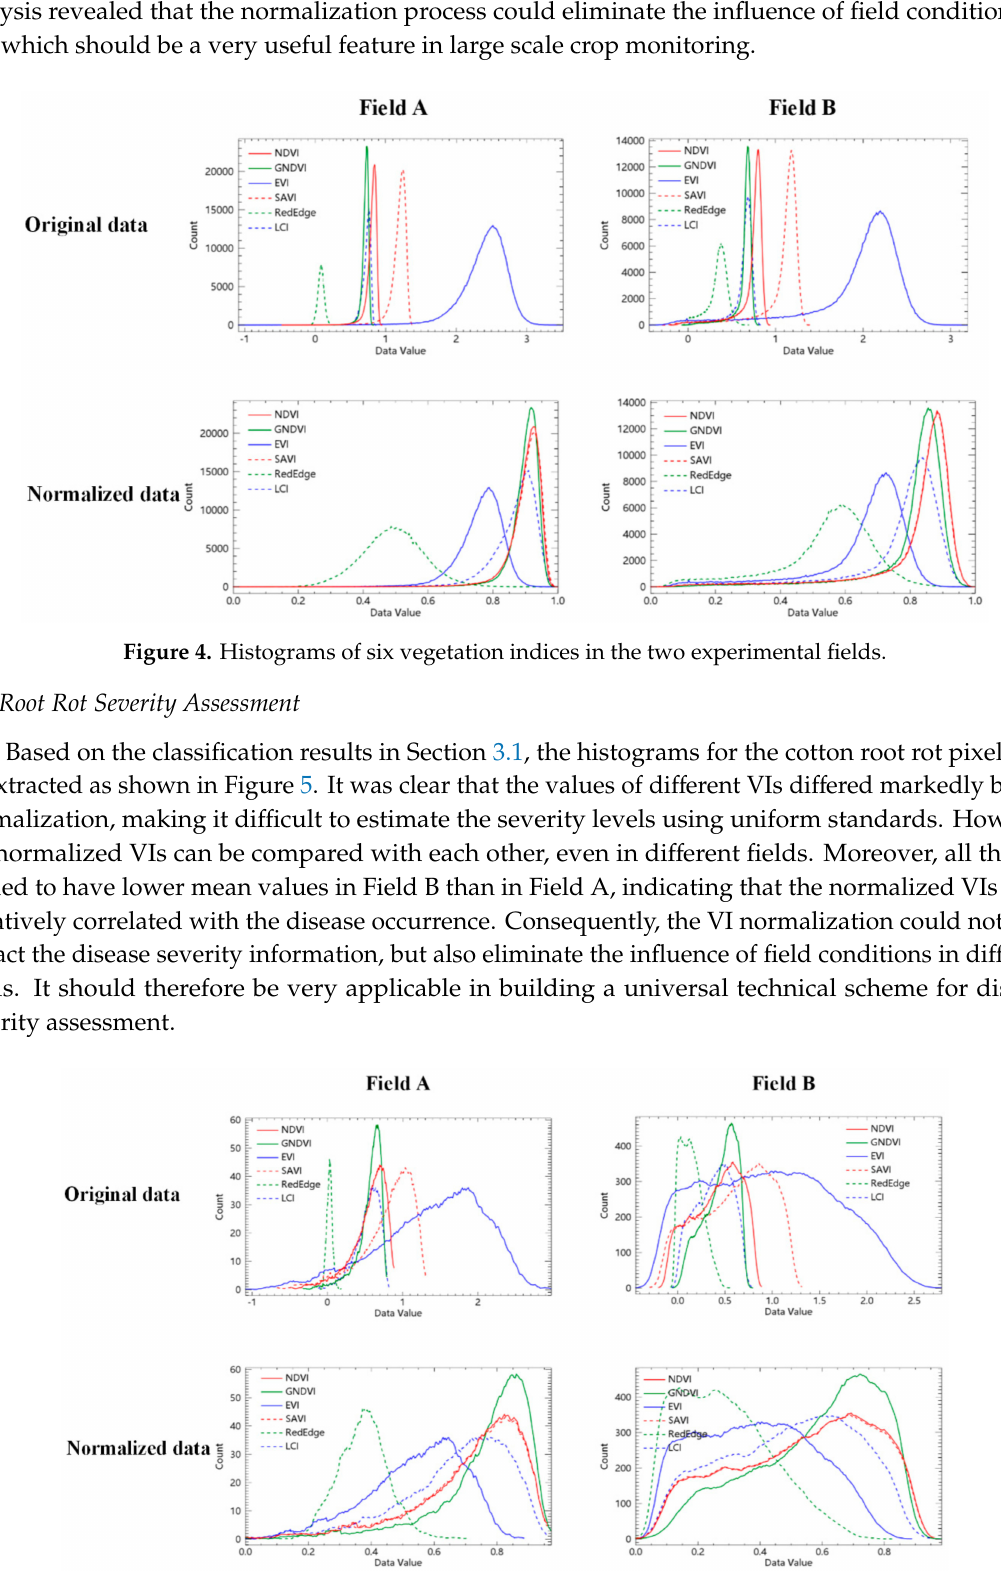
Figure 5. Histograms of six vegetation indices in cotton root rot-infested